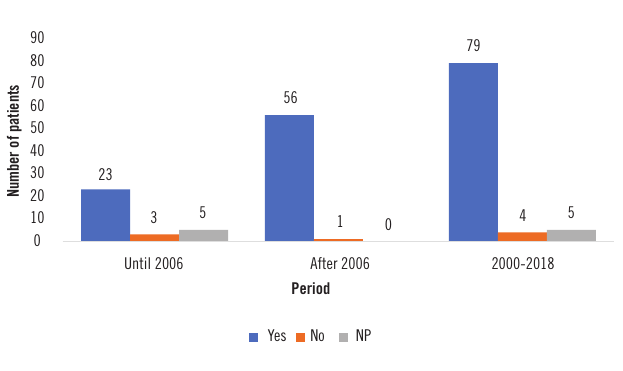
Figure 1: Multiparametric Flow Cytometry tests suggestive of APL (yes, no or not done), before figurE 1 – MFC tests suggestive of APL (yes, no or not performed), before and after and after 2006, and in the total period of study. ND: Not done 2006, and in the total study period